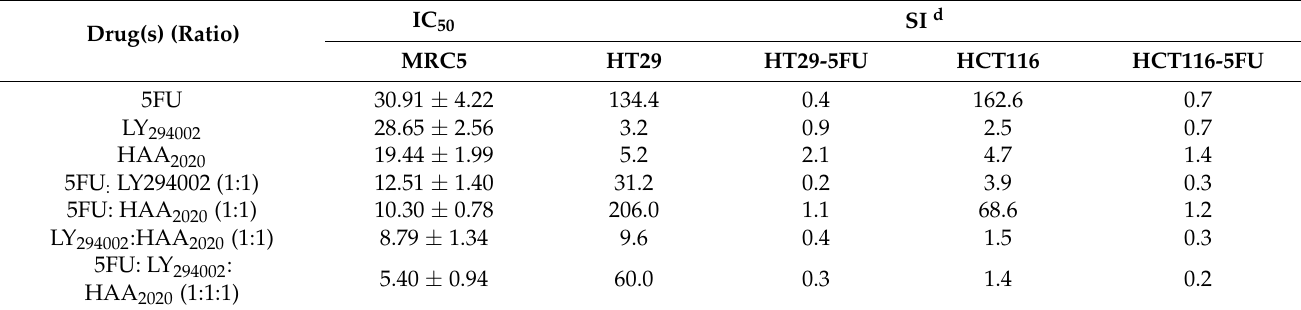
Table 5. IC 50 values (72 h mean ± SD, µ M) and selectivity index of 5FU, LY294002, HAA 2020 , and their combinations in MRC5 cells. Experiments were repeated × 3 ( n =